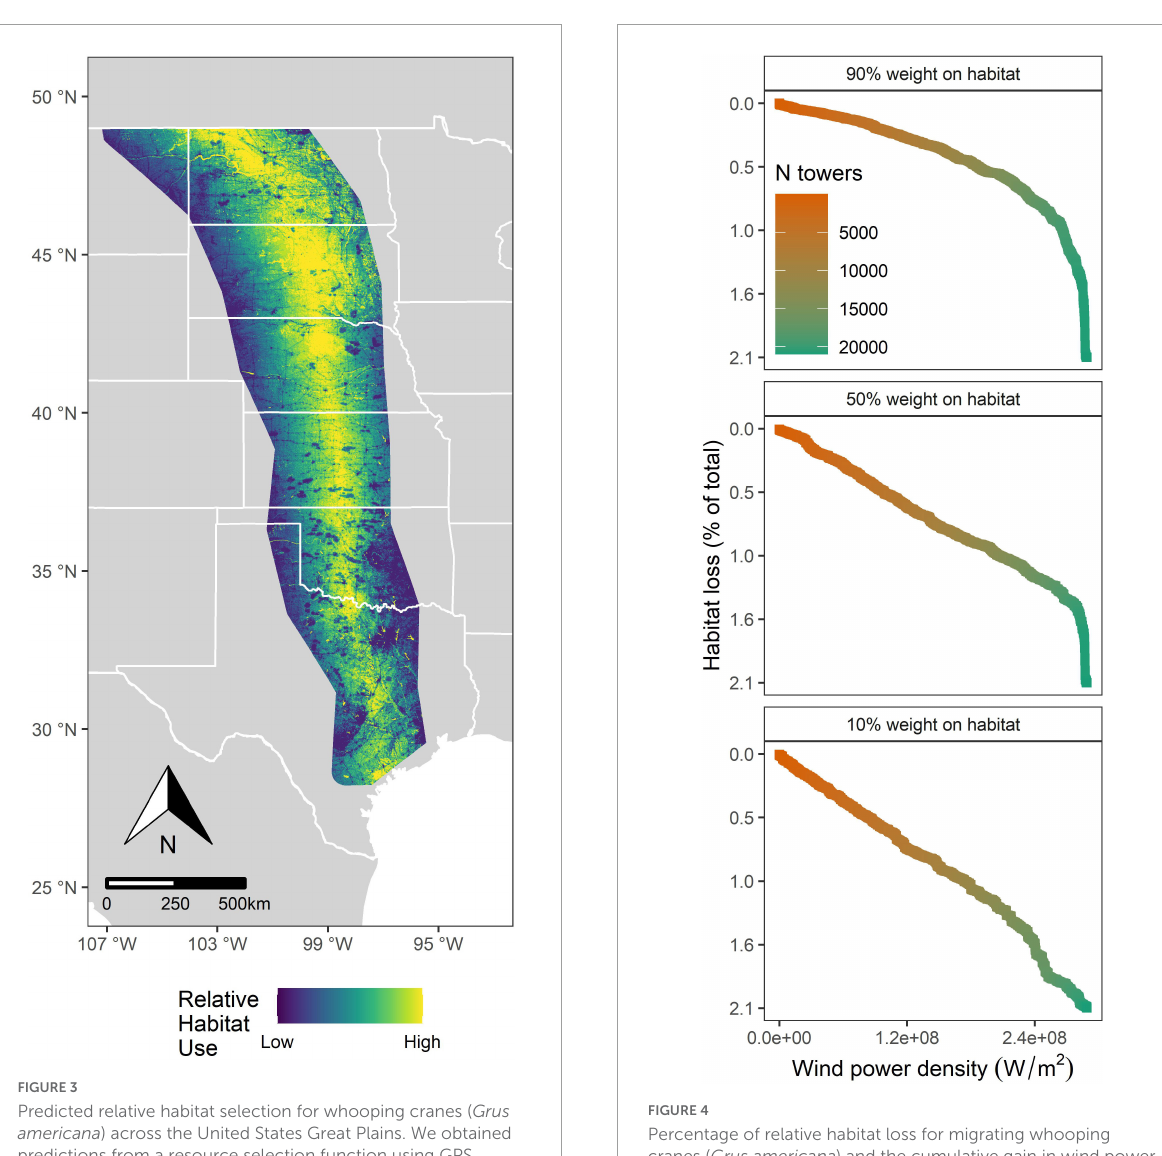
FIGURE3 Predicted relative habitat selection for whooping cranes ( Grus americana ) across the United States Great Plains. We obtained predictions from a resource selection function using GPS locations between 2010 and 2016 during migration. This surface is a composite of drought and non-drought conditions calculated using the average drought occurrence at each pixel during our study period.